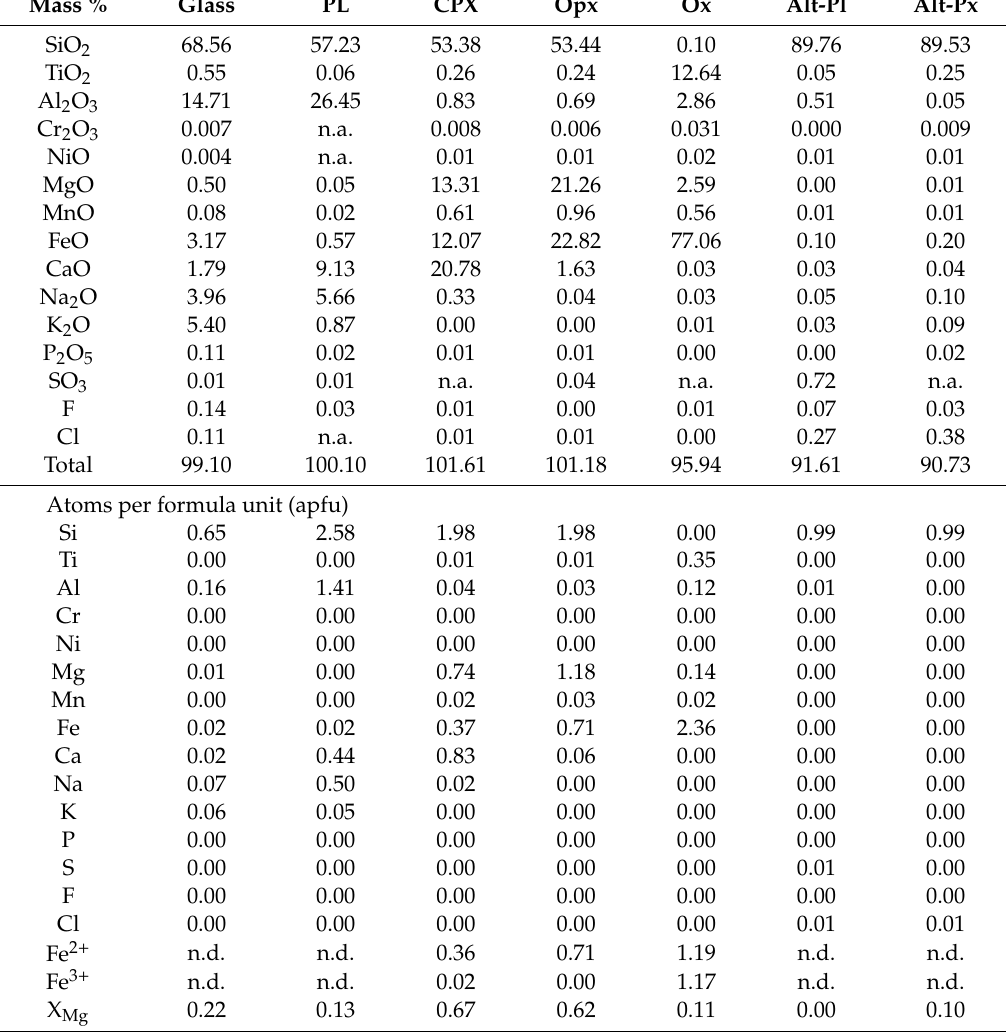
Table 1. Mean major element compositions of the andesite phenocrysts and glass, and their alteration products as determined by WDS-EPMA. Atoms per formula unit (apfu) values normalised to the mineral cation sum, and to 1 for glass and the opaline silica alteration product. Values for Fe 2 + and Fe 3 + are calculated from the di ff erence between cation and anion sums, and X Mg only